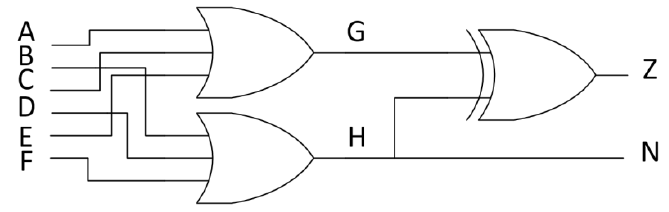
Figure 4. Data transcoding logic.